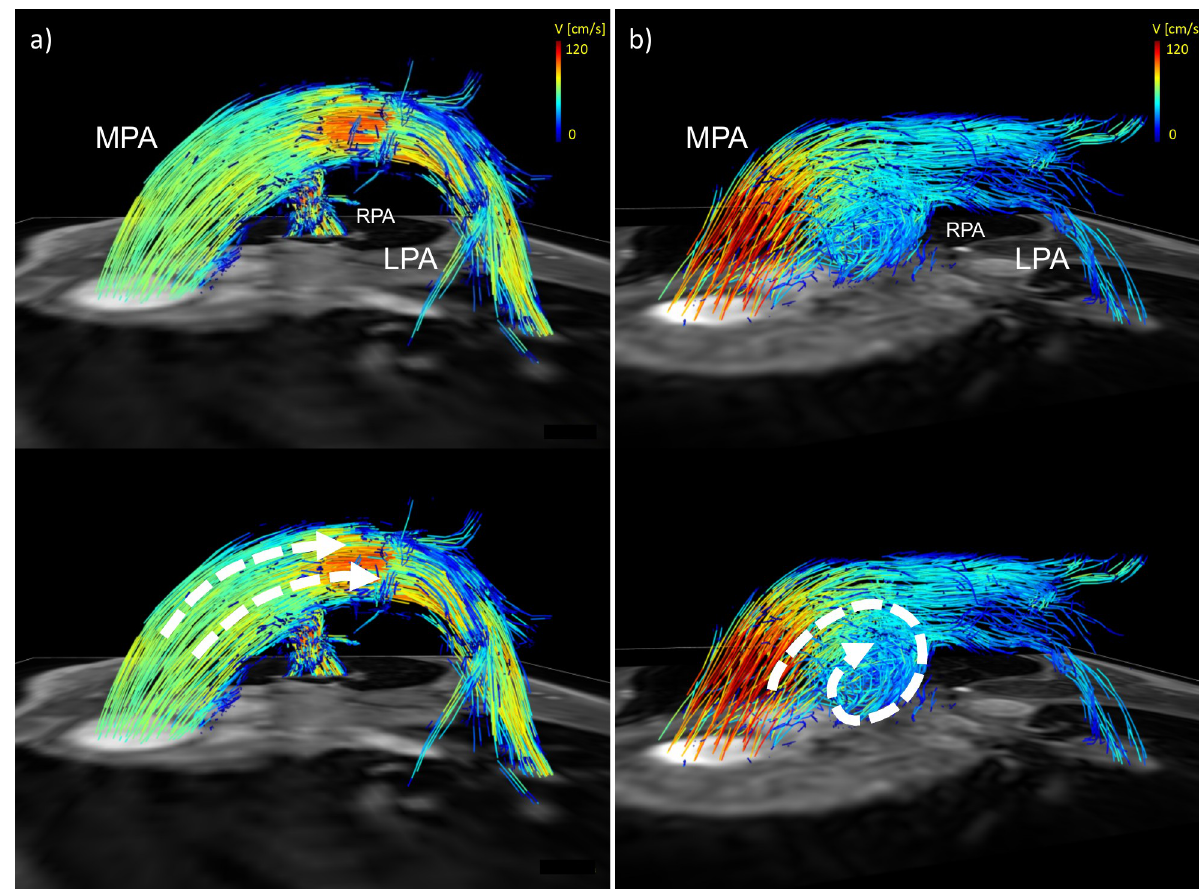
Fig 5. Visualization of macroscopic bloodflow in a healthy volunteer and a patient with PH. The volunteer (a) shows physiological laminar flow without any secondary flow patterns whereas the patient (b) demonstrates a vortex in the MPA, indicating an increased mean pulmonary artery